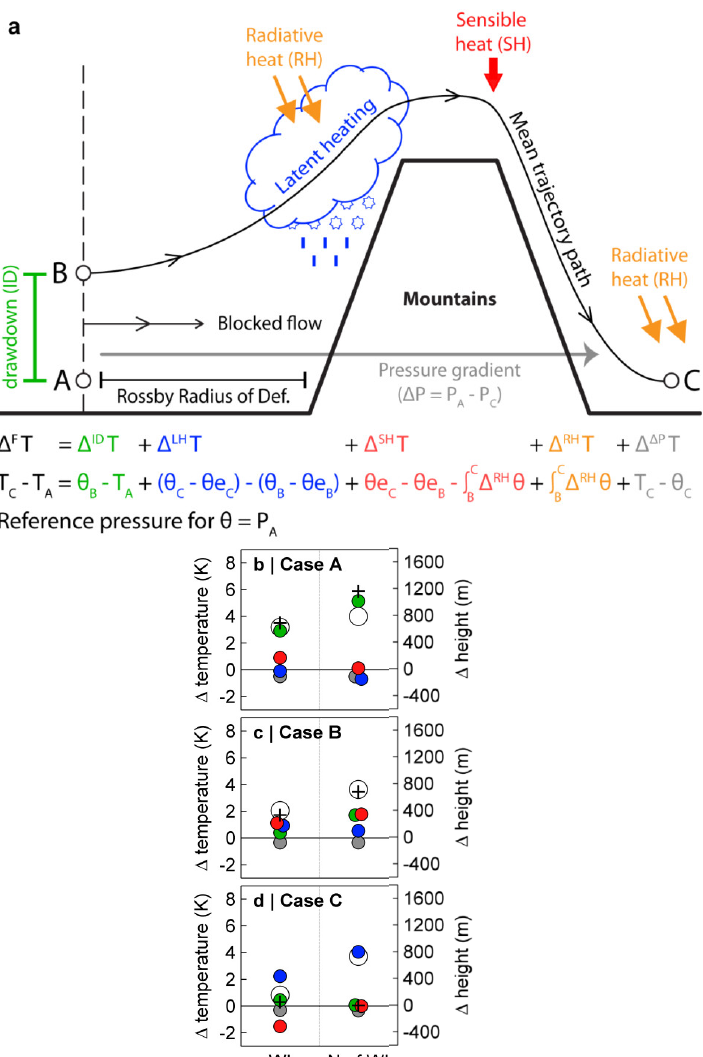
Figure 2. Foehn heating contributions. Panel ( a ) illustrates the Lagrangian heat-budget model for air passing over a mountain and experiencing the following foehn warming mechanisms: Isentropic drawdown (Δ ID T), latent heating and precipitation (Δ LH T), sensible heating due to mechanical mixing (Δ SH T), and radiative heating (Δ RH T), as well as a pressure-gradient related cooling (Δ ΔP T). These contributions sum to a total foehn heating (Δ F T). Panels ( b – d ) show the foehn heating contributions as a change in temperature (K). The total foehn warming is plotted as a large open circle and the heating contributions are colour coded: Isentropic drawdown (green), latent heating (blue), sensible heating through mixing (red), and pressure-gradient cooling (grey). In these cases, the radiative heating contribution is negligible. Also shown is the cross-mountain descent (+). Six heat-budgets are illustrated, for three cases of foehn in Whirlwind Inlet (WI) and a region north of Whirlwind Inlet (N of WI)—see Figure 1 for locations. (Adapted from Reference [9]).